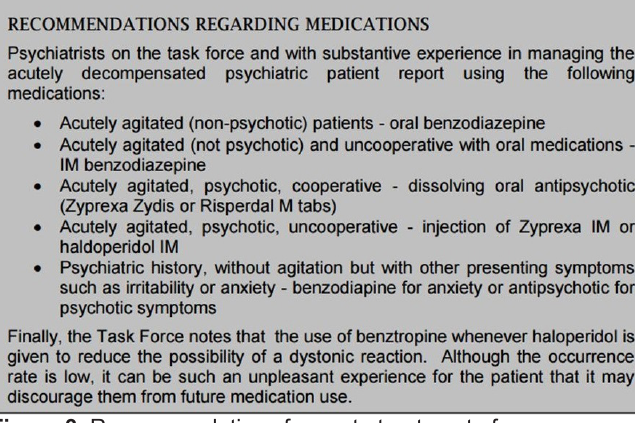
Figure 3 . Recommendations for acute treatment of emergency department patients with